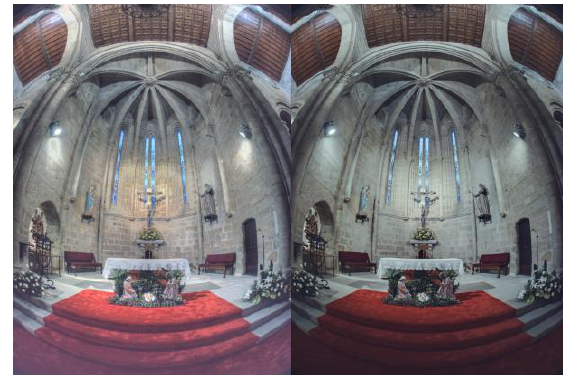
Figure 4. HDR gained from tone mapping in Photomatix (default settings) on the left and HDR gained from exposure fusion in NCTech ImmersiveStudio.